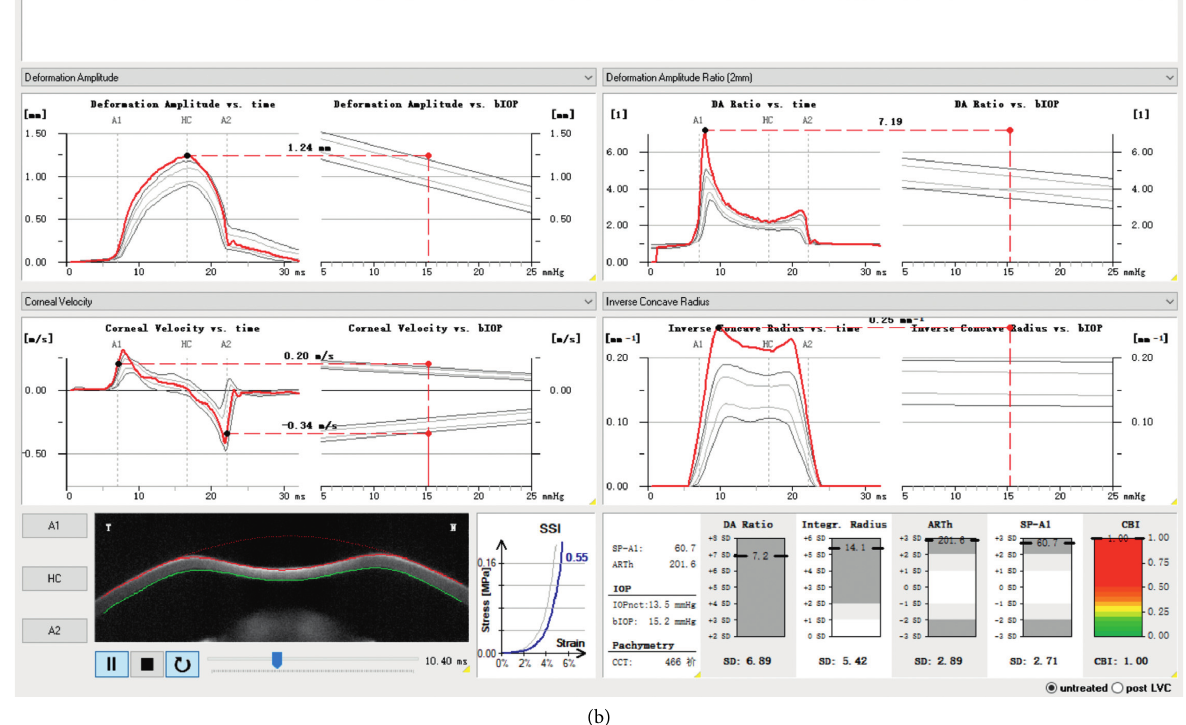
Figure 1: Vinciguerra Screening Report showing calculation of stiffness parameters (first applanation (SP-A1) and stress-strain index (SSI)) for post-LASIK ectasia (a) and primary keratoconus (b) with matching age and central corneal